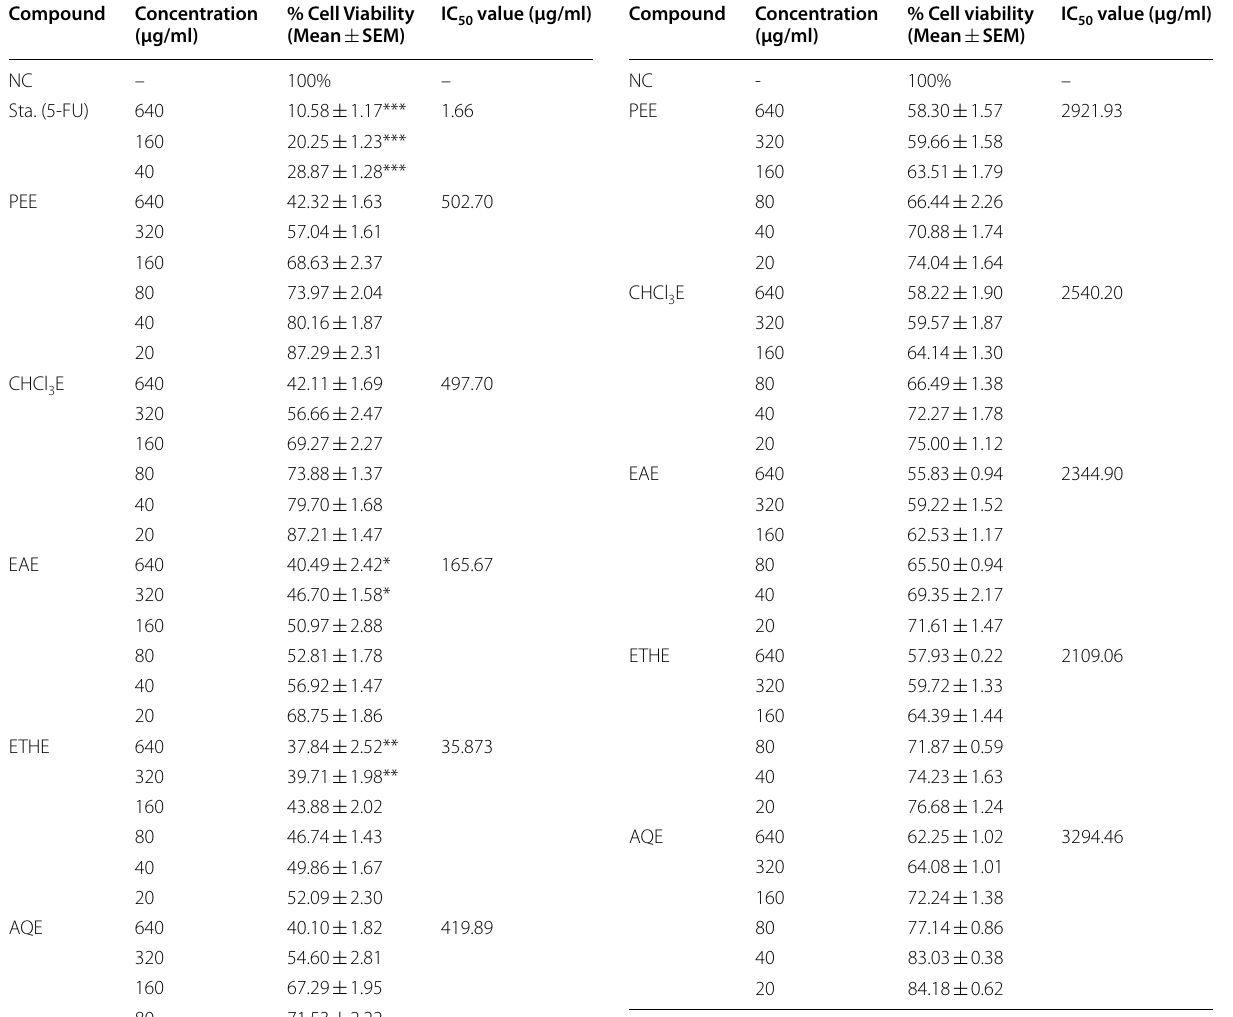
Table 1 Effects of different leaf extracts of Convolvulus pluricaulis on Liver Cell Line-HepG2